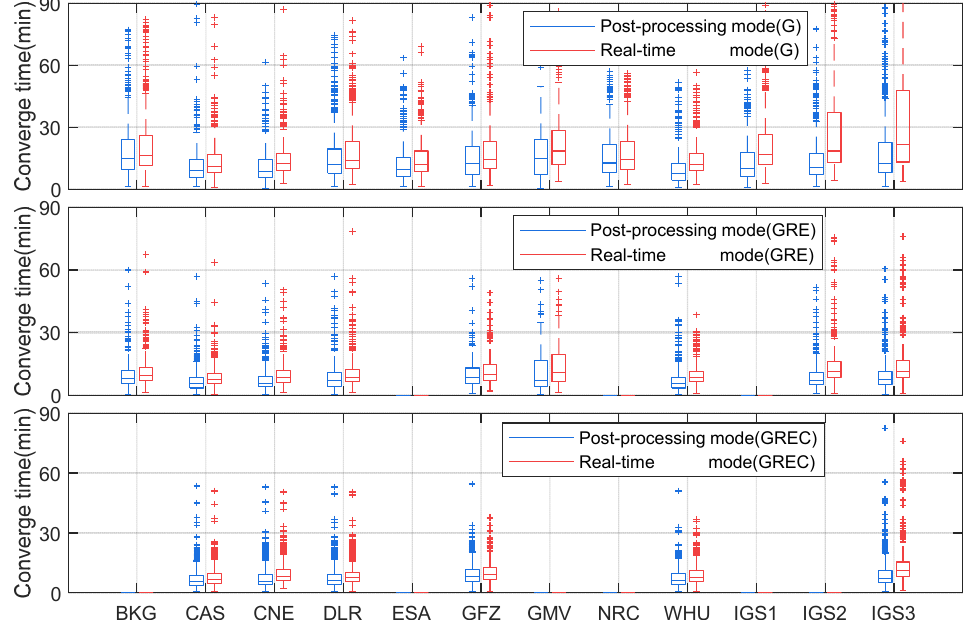
Figure 8. The convergence time of static PPP using different SSR products for 16 IGS stations. For the post-processing mode, the products of WHU had the shortest mean conver- gence time for GPS only with a median of 7.5 min, while the products of BKG had Furthermore, the convergence speed of the GPS/GLONASS/Galileo (GRE) combina- tion for the two modes was significantly faster than that of GPS only, which mainly ben- efited from the increased number of satellites especially for Galileo satellites. The median convergence time of the GRE combination ranged from 5.5 min to 8.5 min in post-pro- cessing mode for different real-time products, while it ranged from 7.5 min to 11.5 min in real-time mode. Compared to the results with GPS only, the convergence time with the GRE combination for different real-time products reduced by 26.7% ~ 51.7% in post-pro- cessing mode and reduced by 29.2% ~ 46.5% in real-time mode. In addition, the results with the GRE combination for those SSR products which were unstable or had large la- tency had a more positive effect on the convergence speed, such as the results of IGS03 had the largest improvement in convergence speed with 46.5% in real-time mode. The smallest improvement was those of WHU with a value of 29.2% in real-time mode. As for the GPS/GLONASS/Galileo/BDS (GREC) combination, the convergence speed showed a small improvement over the results of the GRE combination, and the improvement for different real-time products was not more than 14.3%. In some ways, the little improve- ment was limited by the continuity of BDS corrections. Therefore, the real-time services may need to pay more attention to the satellite model and continuity of BDS corrections to ensure the multi-GNSS real-time applications in the future. Moreover, compared to the GRE combination, the abnormal results of the GREC combination were obviously re- duced. Figure 9 presents the positioning accuracy of static PPP for different SSR products. The positioning errors for static PPP in real-time mode are slightly larger than in post- processing mode. The positioning accuracy of GMV in real-time mode was worse than in post-processing mode, which was mainly because the instability of GMV SSR corrections. On the whole, the results of static PPP in real-time mode with GPS only for all SSR prod- ucts had an accuracy of better than 3.2 cm in the horizontal and 2.5 cm in the vertical directions, respectively. The best performance results were from WHU with a mean RMS